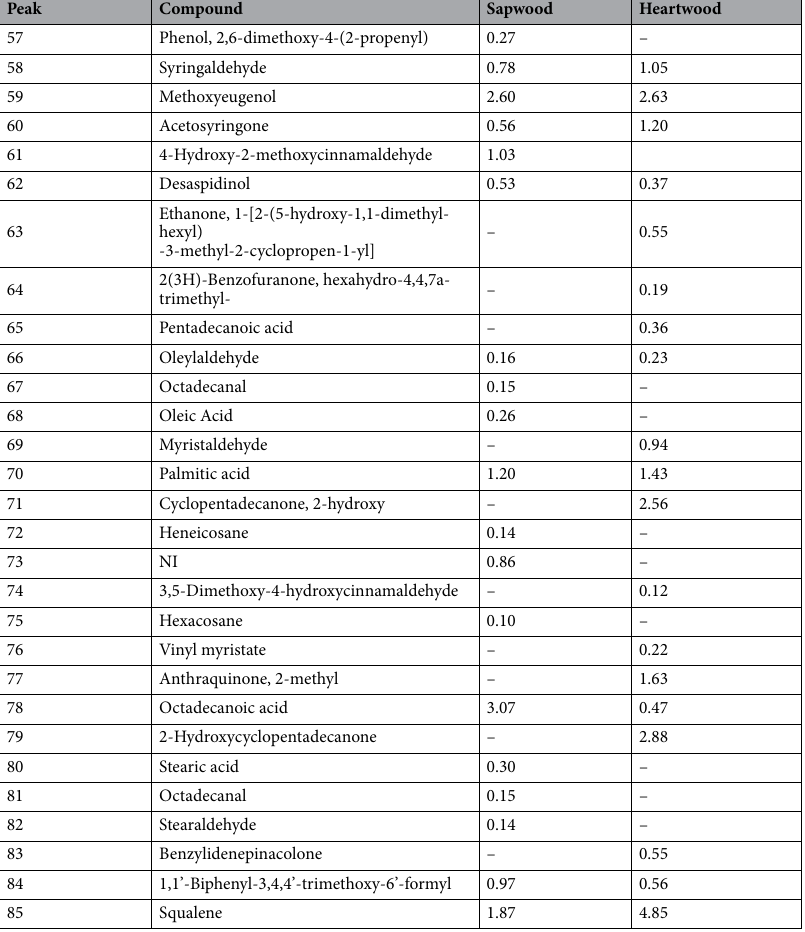
Table 1. Area of the pyrolytic compounds peaks (percentage of the total chromatogram area) of the teak sapwood and heartwood. NI The compound was not